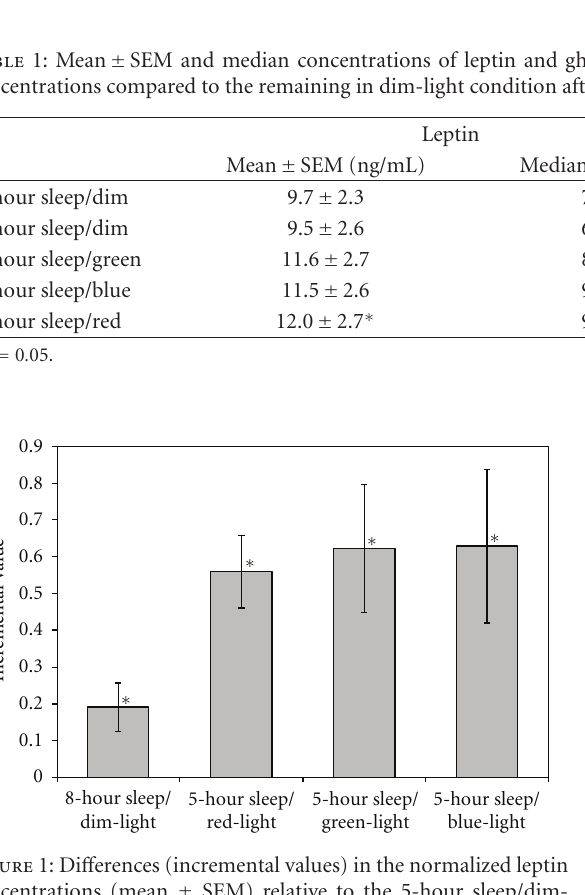
Figure 2: Di ff erences (incremental values) in the normalized ghrelin concentrations (mean ± SEM) relative to the reference, 5- hour sleep/dim-light condition. Sample concentrations collected at 60, 90, and 120 minutes for the 8-hour sleep/dim-light condition, those for the 5-hour sleep/red-light condition, those for the 5-hour sleep/green-light condition, and those for the 5-hour sleep/blue- light condition were each normalized to the values obtained at 60, 90, and 120 minutes for the reference, 5-hour sleep/dim-light condition. These normalized values were averaged across subjects and times. The incremental values reflect the di ff erence in the averages of the four di ff erent sleep/lighting conditions from the 5-hour sleep/dim-light condition. Incremental values after the 5- hour sleep/red-light and 5-hour sleep/green-light conditions were significantly lower than those in the reference, 5-hour sleep/dim- light